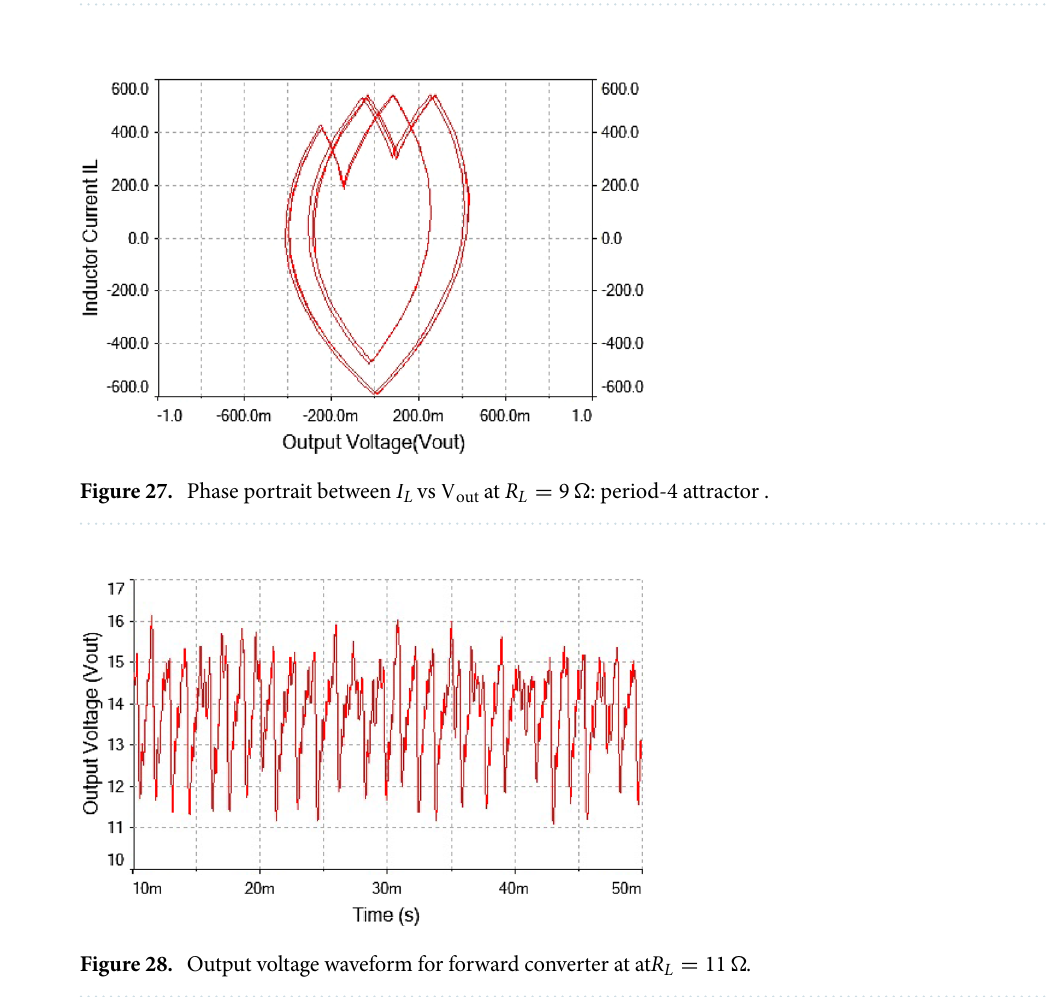
Figure 26. Inductor current waveform for forward converter at R L = 9 (cid:31) .